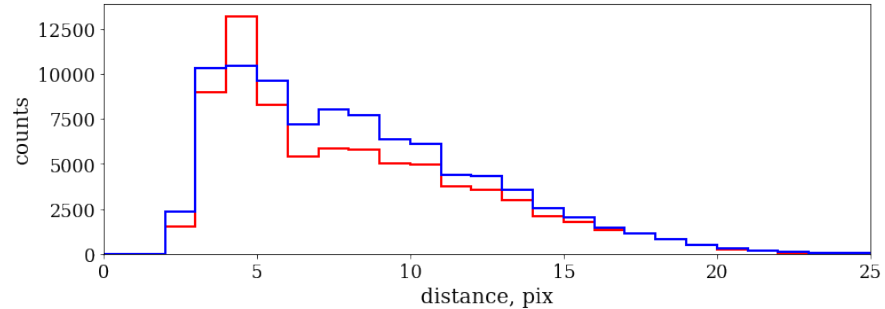
Figure 9. Distribution of distances between the photon pairs in the same fiber for fiber 1 (red) and fiber 2